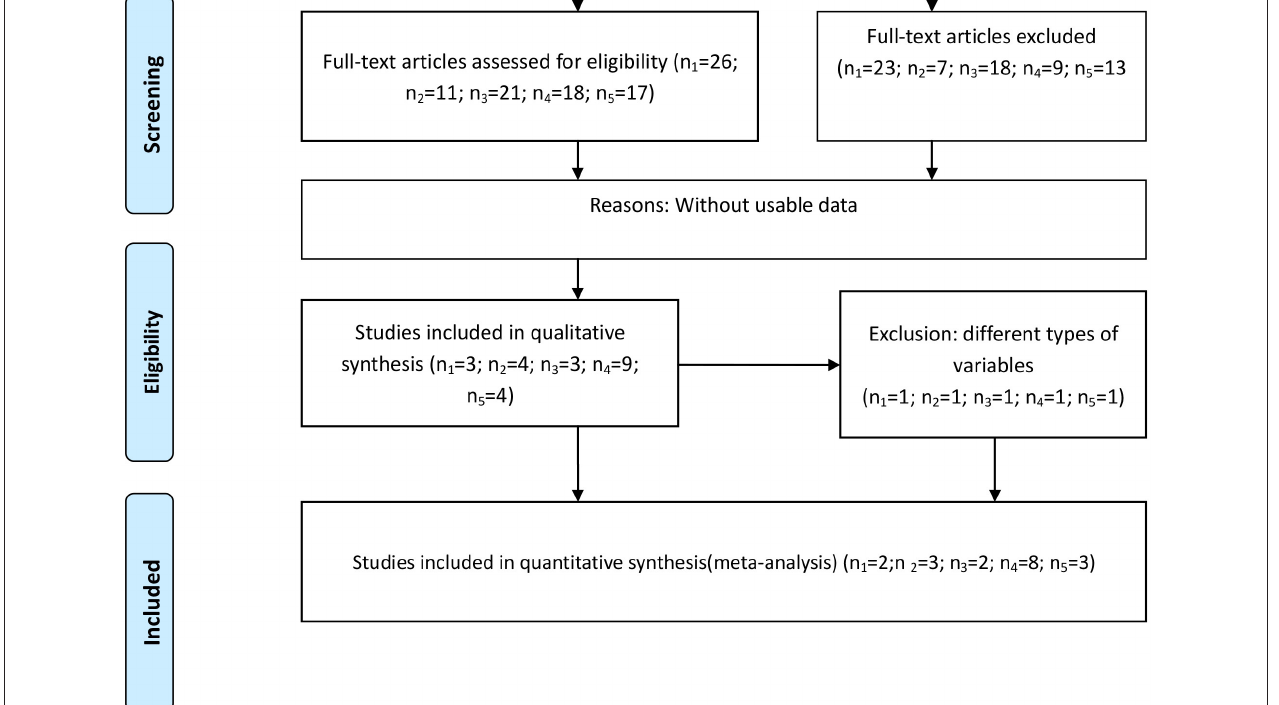
Frontiers in Neurology | www.frontiersin.org